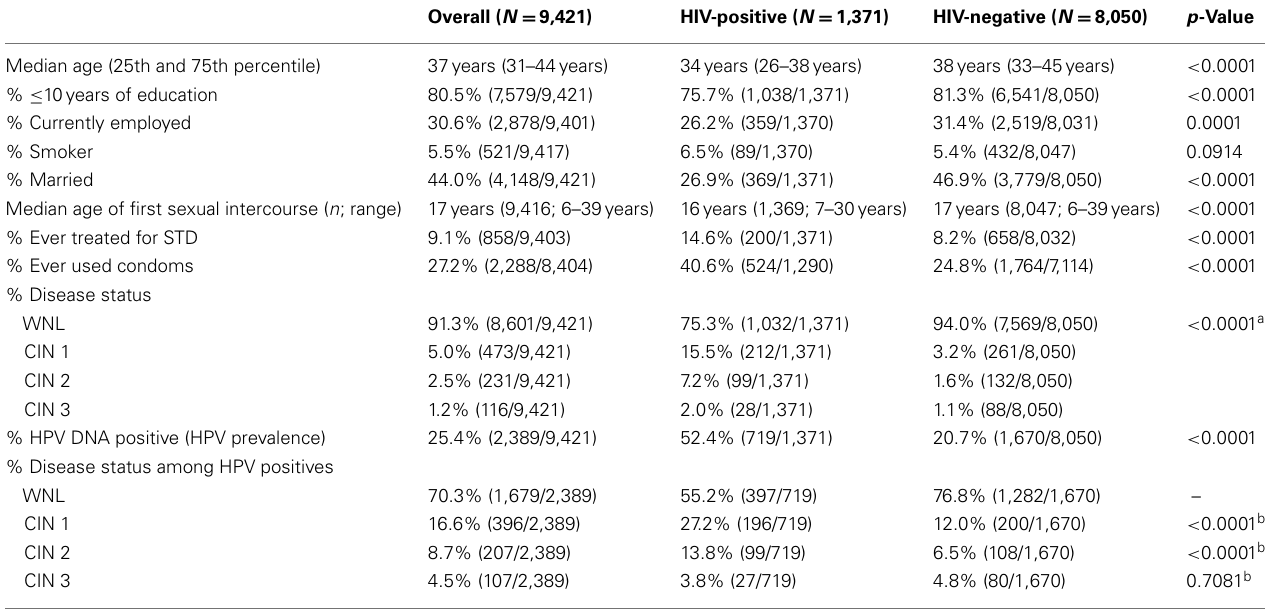
Table 1 | Characteristics of HIV-positive and HIV-negative women who participated in cervical cancer screening studies in Khayelitsha, South Africa .